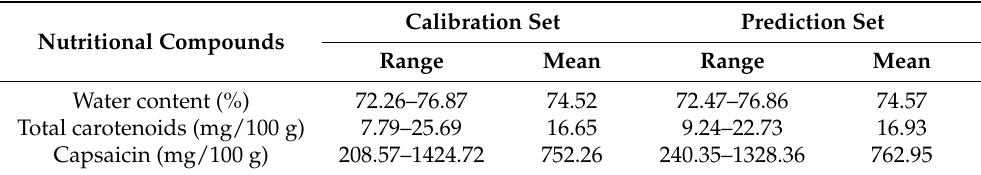
Figure 1. Original spectra for green ‘Ratuni UNPAD’ cayenne pepper. Table 1. Summary of laboratory analysis of water content, total carotenoids, and capsaicin in calibration set and prediction set.